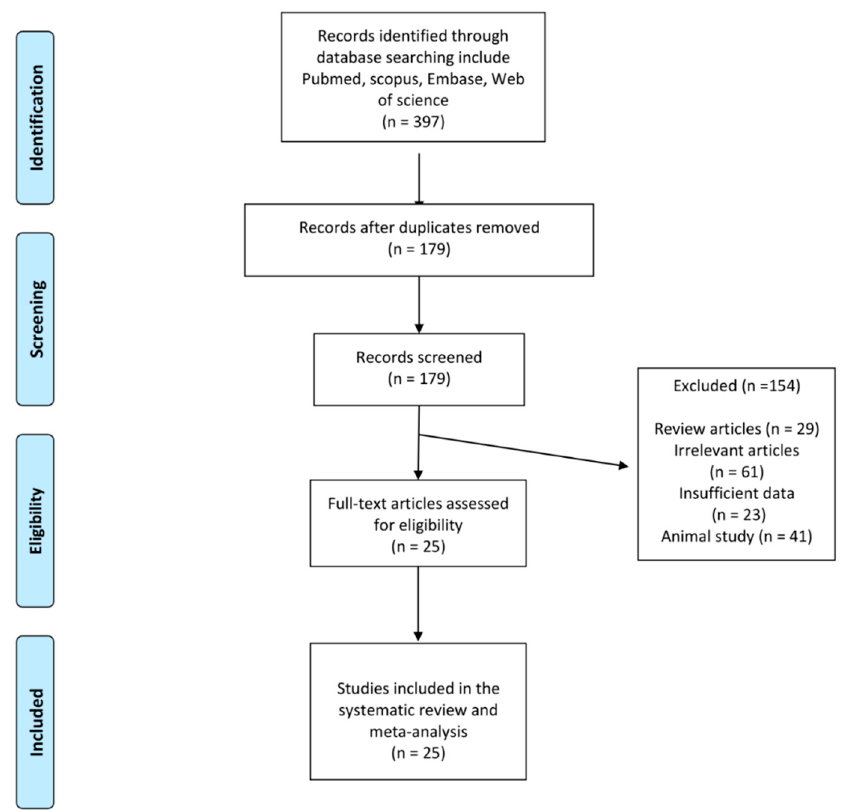
Figure 1. Flow chart of identified publications and those included into meta-analysis. Table 1. Characteristics of studies measuring MCP-1.